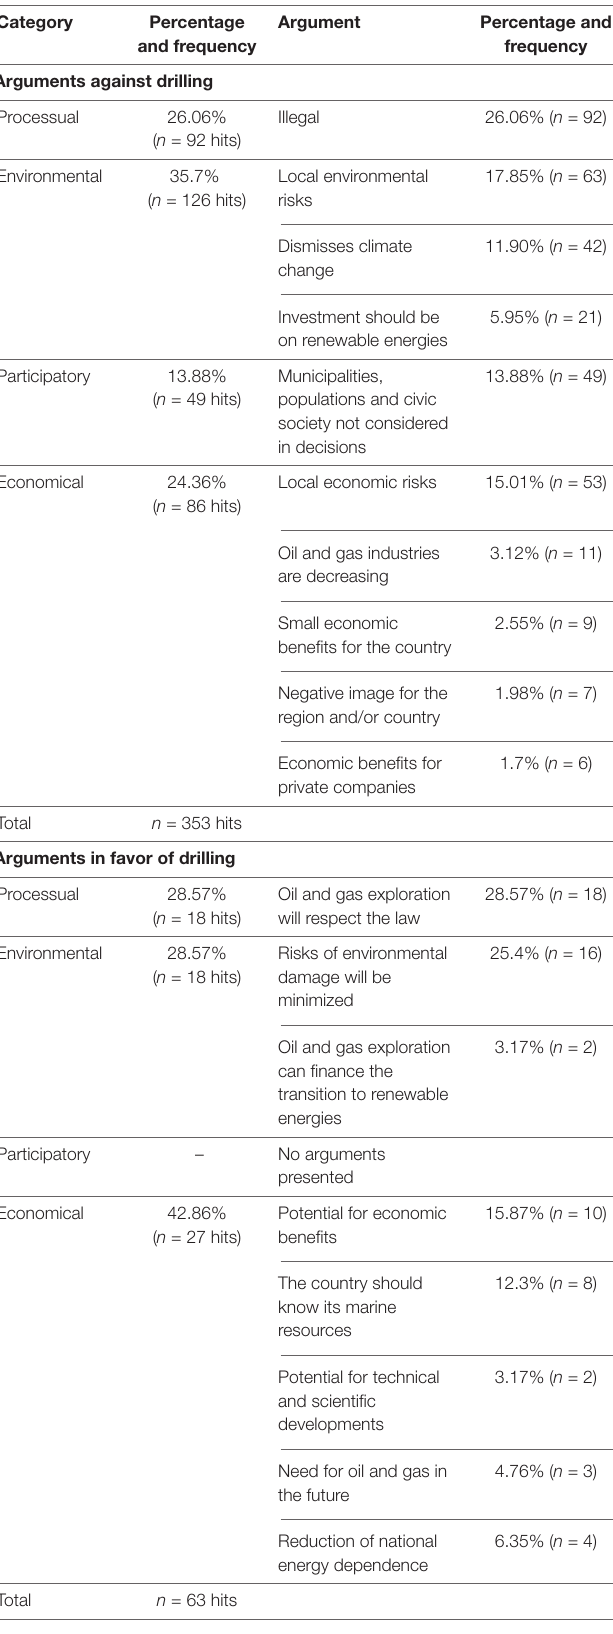
TABLE 3 | Frequency of arguments against and in favor of